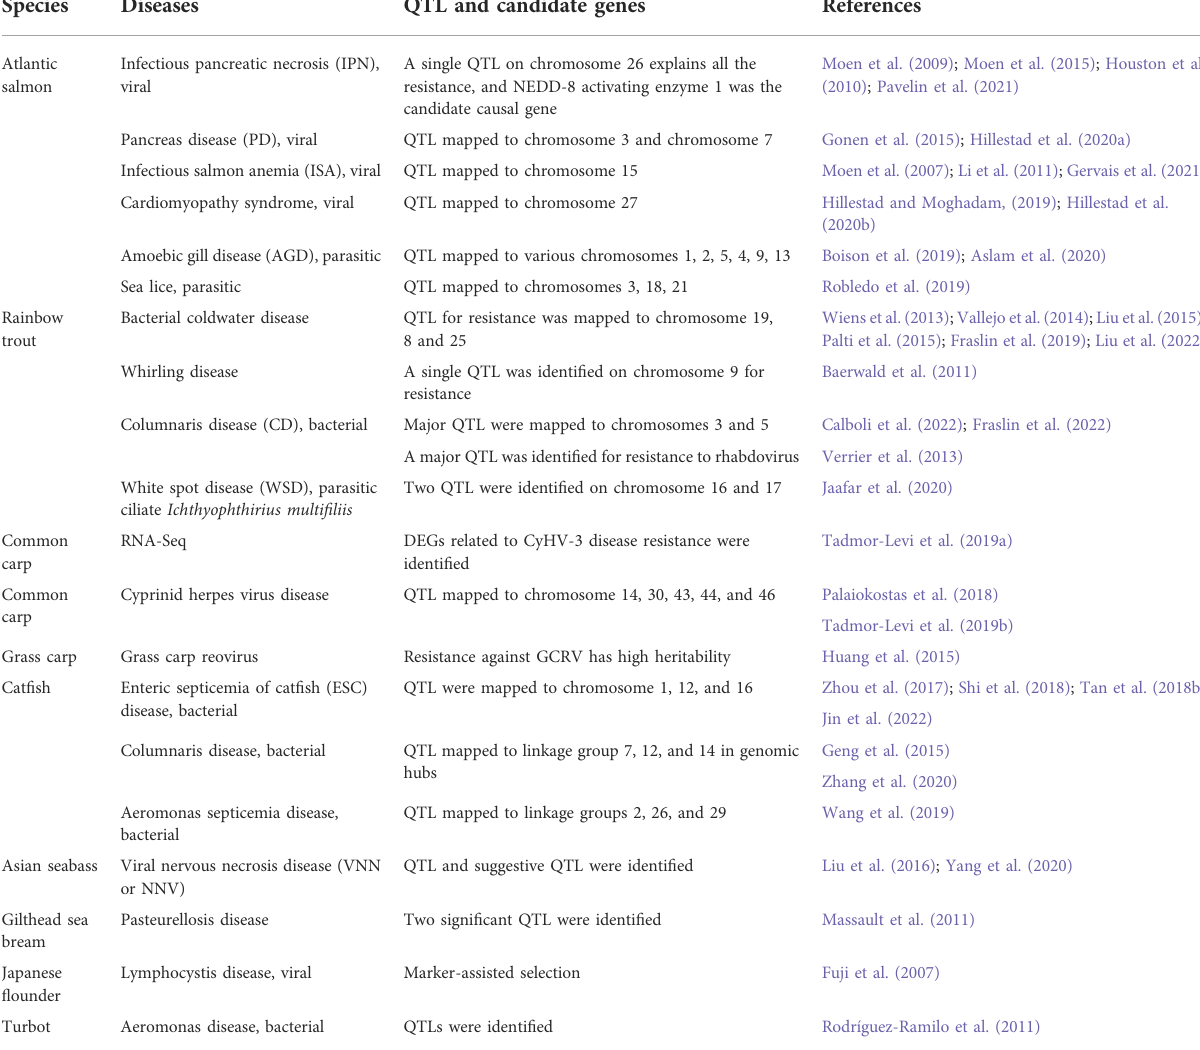
TABLE 2 Some examples of genetic studies of disease resistance in several major aquaculture fi sh